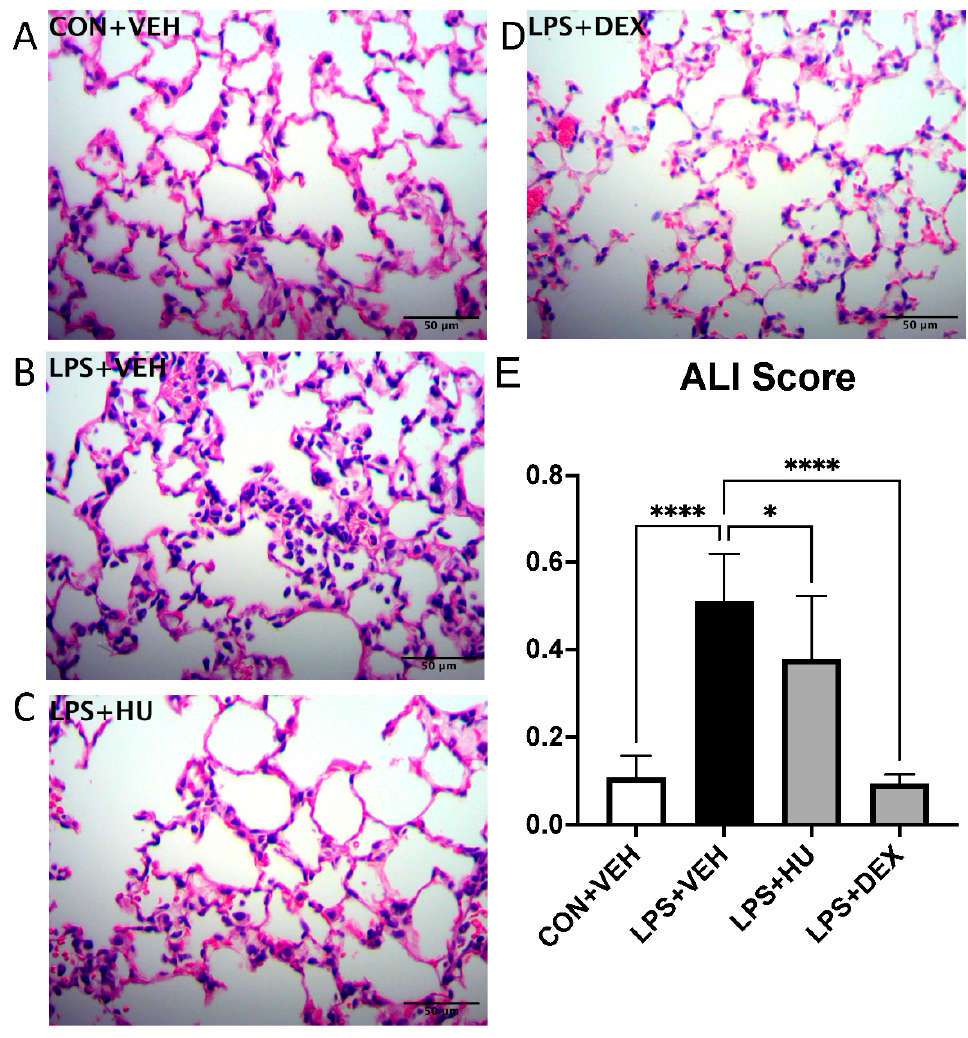
Figure 6. Impact of treatment on LPS-induced lung histopathology. Representative FOV of ( A ) con + veh and LPS + ( B ) veh, ( C ) HU-308, and ( D ) DEX mice. ( E ) Histopathological lung scores. Data are expressed as mean ± SD. Statistically significant differences were determined via one-way ANOVA with Dunn’s multiple comparisons test and are depicted as * p ≤ 0.05, **** p ≤ 0.0001.